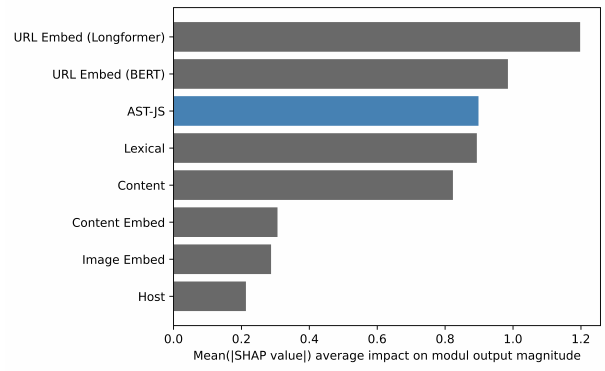
Figure 6. Average SHAP value for each feature category.